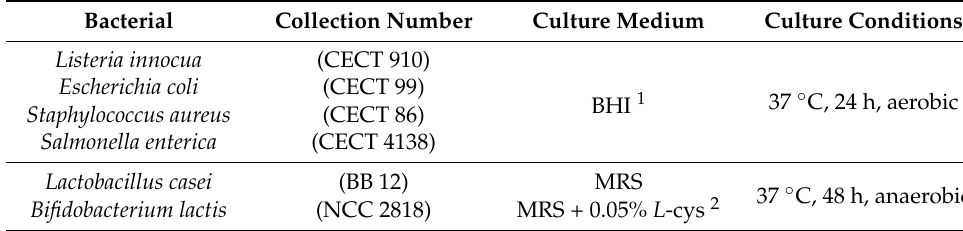
Table 2. The culture conditions of the bacteria used in this